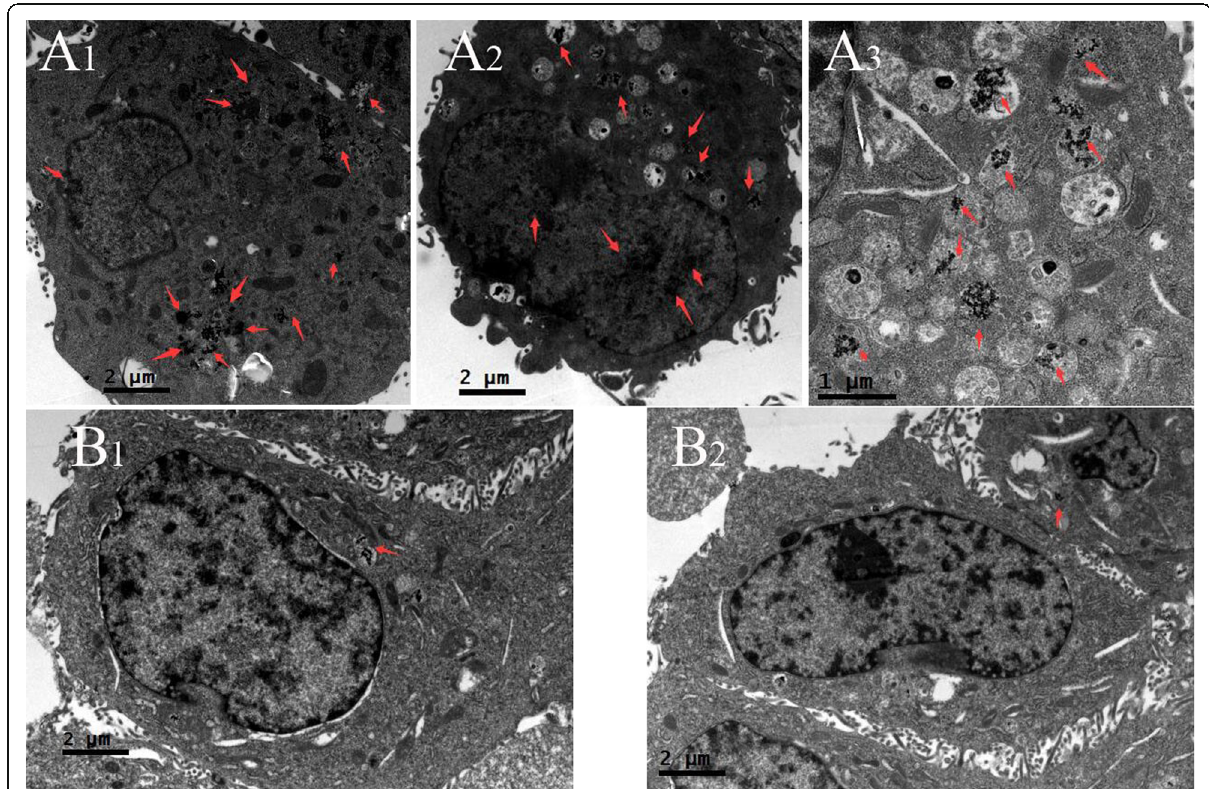
Fig. 5 TEM images of DRN-GNPs incubated in Hela and MCF-7 cells for 24 h. A 1 , A 2 , and A 3 are corresponding to HeLa cells while B 1 and B 2 are to MCF-7 cells